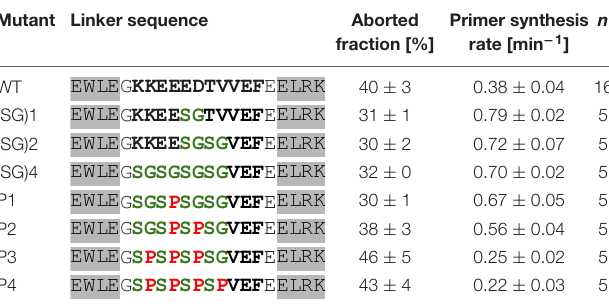
is observed if the longer template T 14 GTGT 3 is used